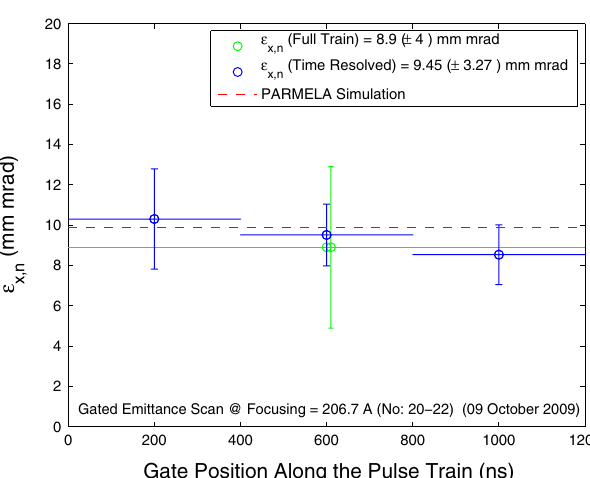
FIG. 12. Emittance measurement along the pulse train with the steps of 400 ns. The charge per bunch and the energy of the beam were 1.6 nC, 4.8 MeV, respectively, during the measurements.